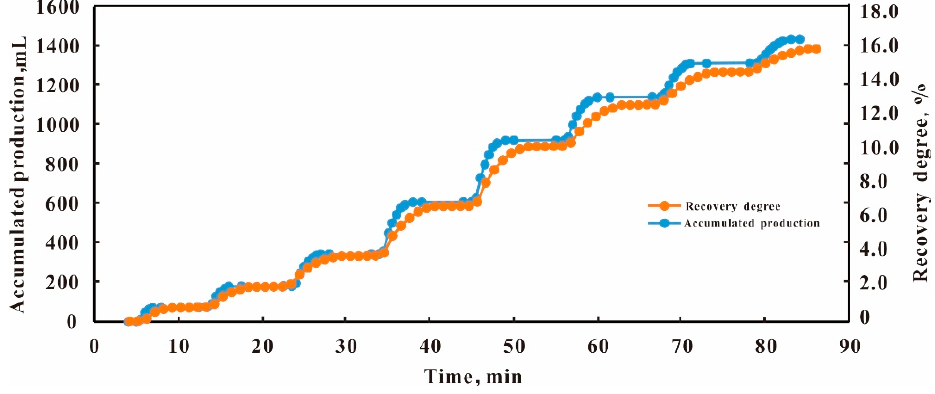
Figure 10. Cumulative oil production and recovery degree of the cyclic stimulation process.